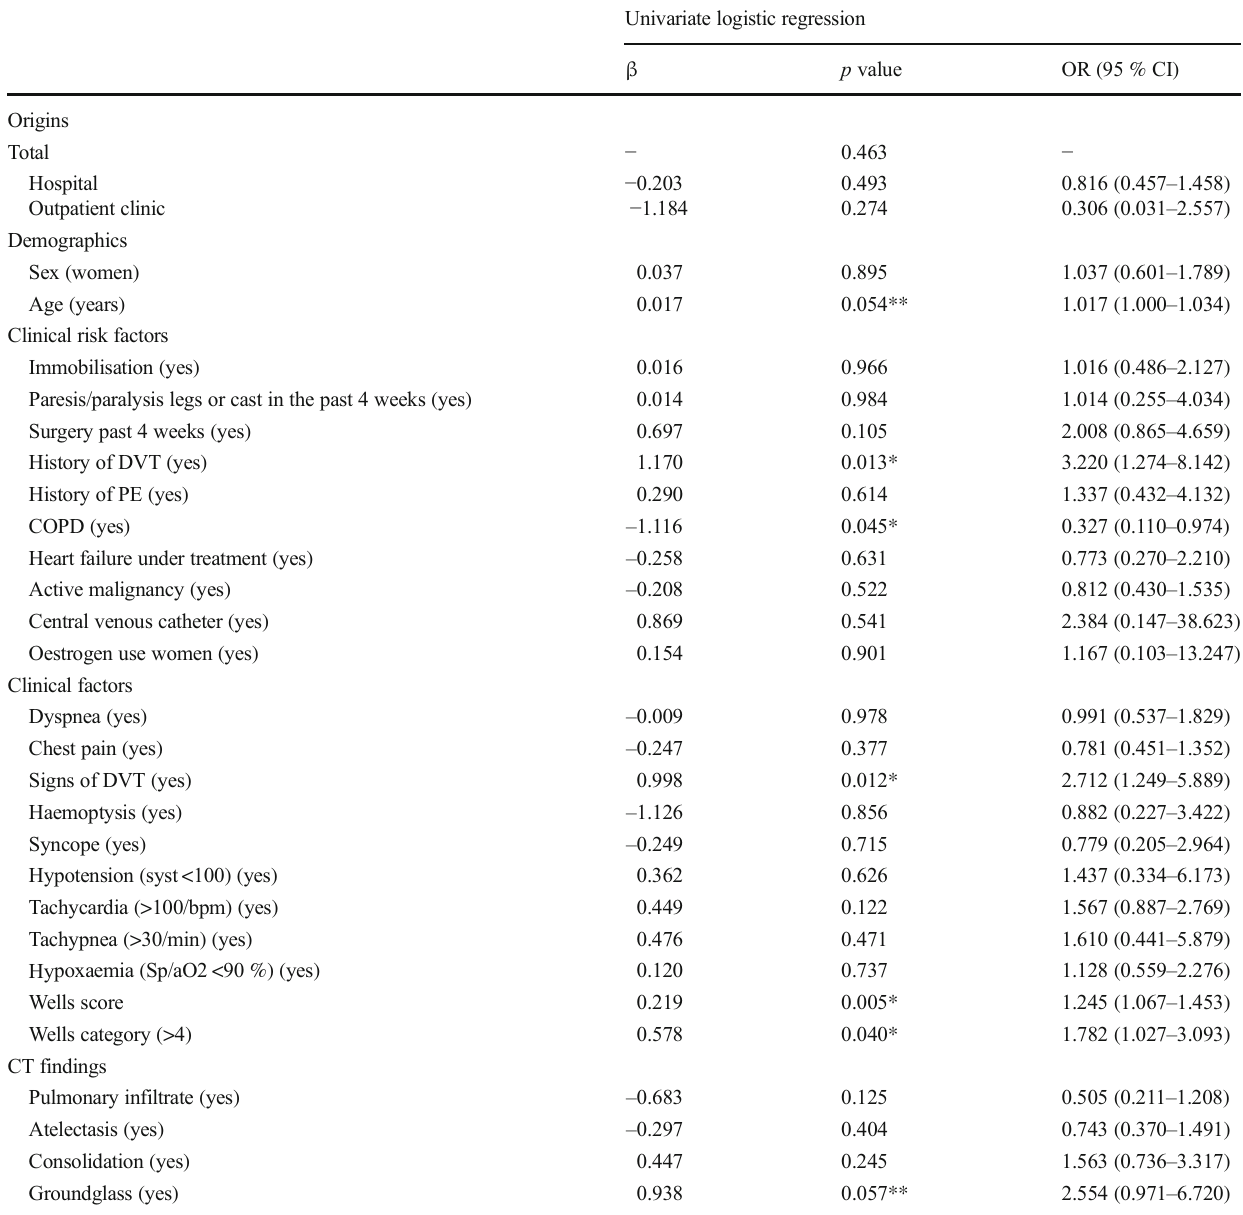
Logistic regression analysis for associates of CTPA-diagnosed pulmonary embolism